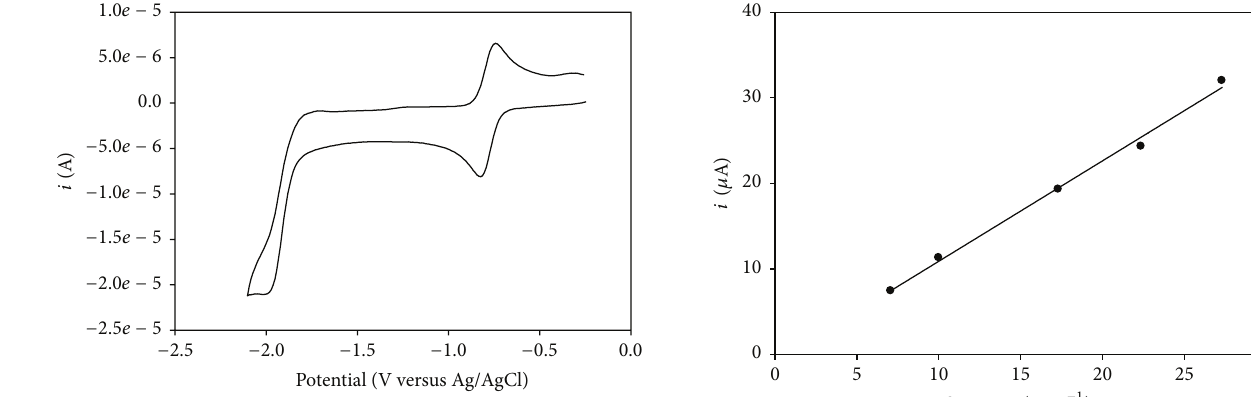
Figure 3: The plots of 𝑖 𝑝 red versus 𝑛 1/2 , Co(I) −1 /Co(0) −2 reduction